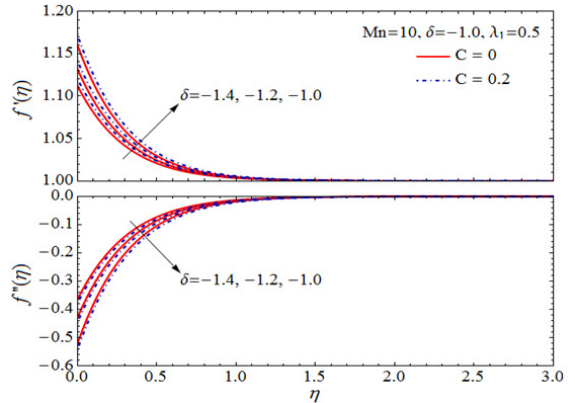
Fig. 7 Dimensionless velocity profile f (cid:48) ( η ) and shear stress profile f (cid:48)(cid:48) ( η ) for various values of λ 1 and C